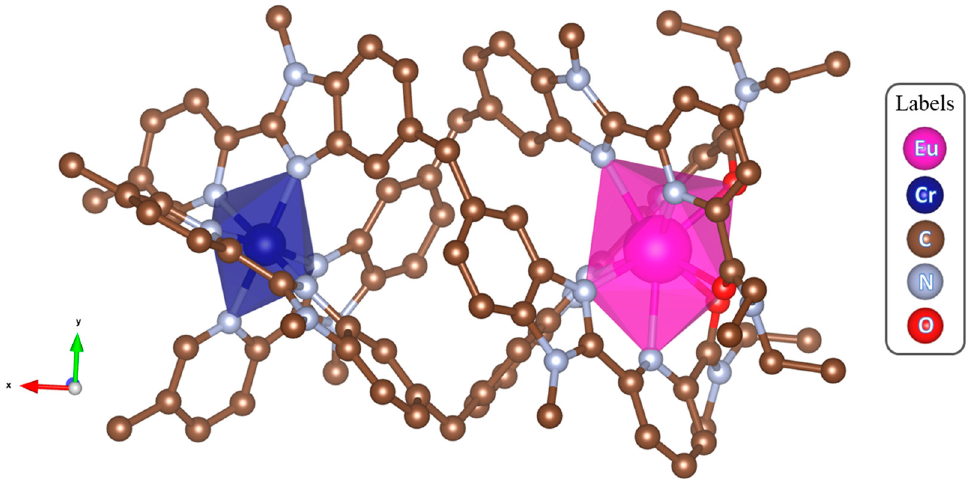
Figure 1. Triple helicate structure of the bimetallic complex [CrEuL 3 ] 6+ highlighting the coordination polyhedrons of Cr and Eu atoms. The geometry was extracted from reference [46] (CCDC code: 176855).